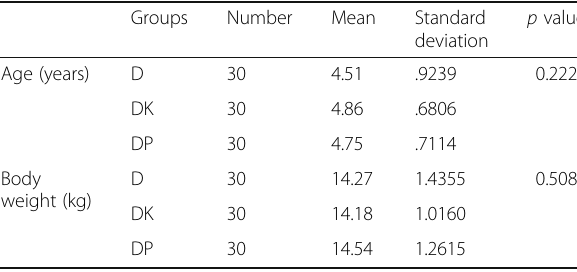
Table 1 Demographic data (age,